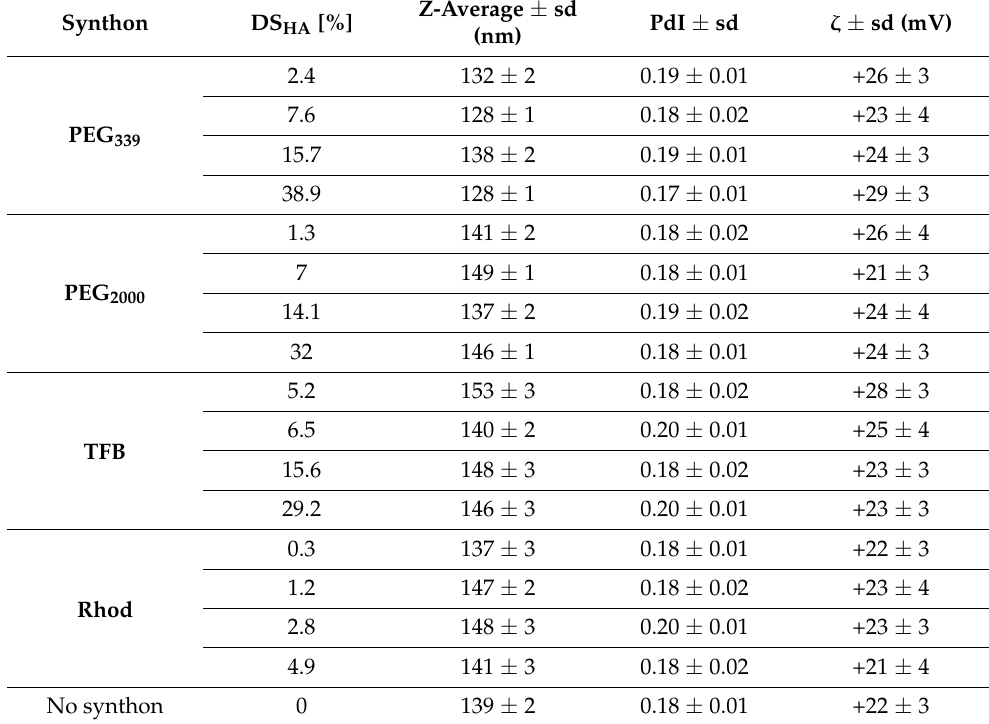
Table 5. Intensity weighted (Z-average) diameters, polydispersity indexes (PdI), and zeta potential ( ζ ) of CS-TPP/functionalized HA nanoparticles according to HA degree of substitution (DS HA